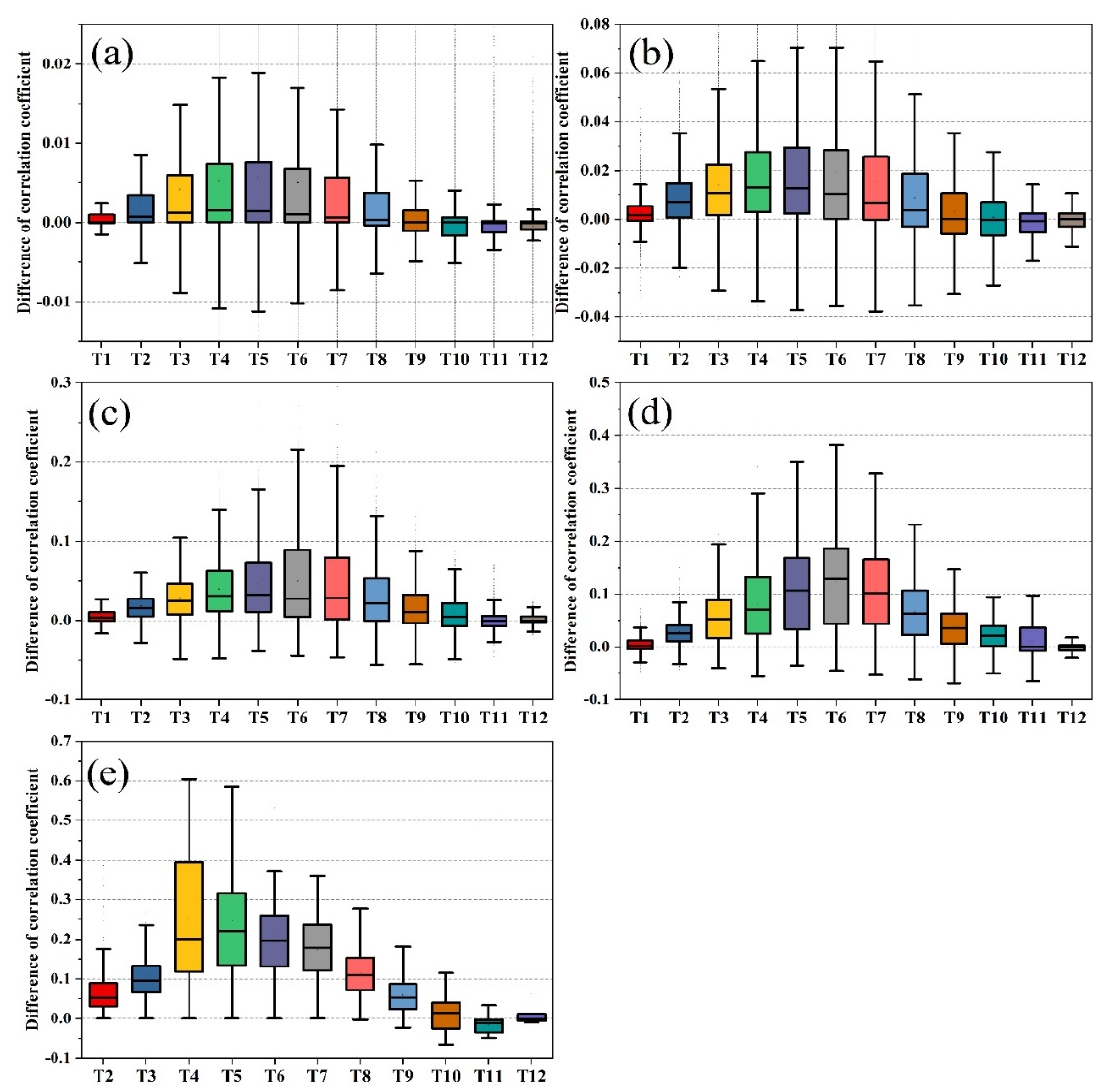
Figure 6. The difference of the response relationship between vegetation to SPEII and SPEI at different time scales at the 0–20% ( a ), 20–40% ( b ), 40–60% ( c ), 60–80% ( d ), and 80–99% ( e ), as well as irrigation levels.